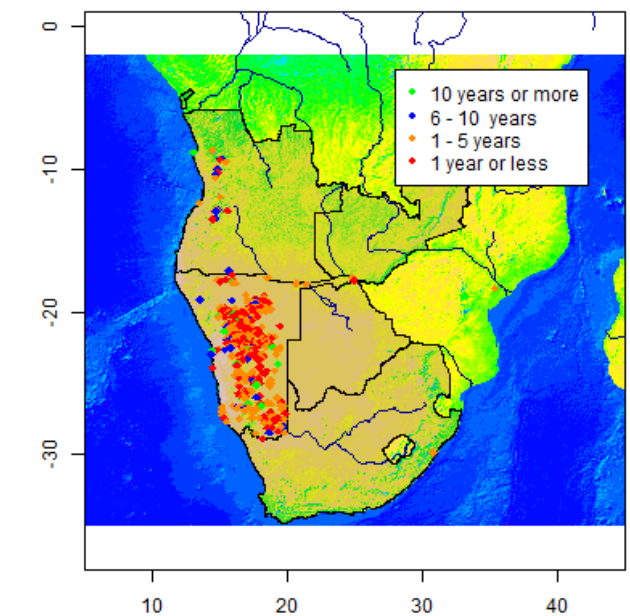
Figure 5. Location and length of the longest observation interval of overseas stations of the German Naval Observatory (“Deutsche See- warte”; 1830–1943) that are available in the archives of Deutscher Wetterdienst as original paper documents. DWD works on the digi- tization of these data (Kaspar et al.,